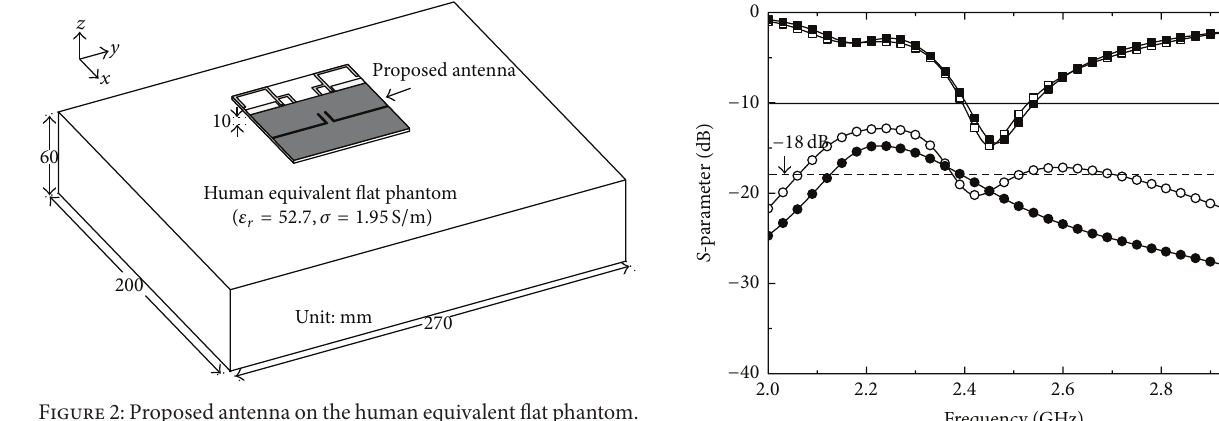
Figure 2: Proposed antenna on the human equivalent flat phantom.